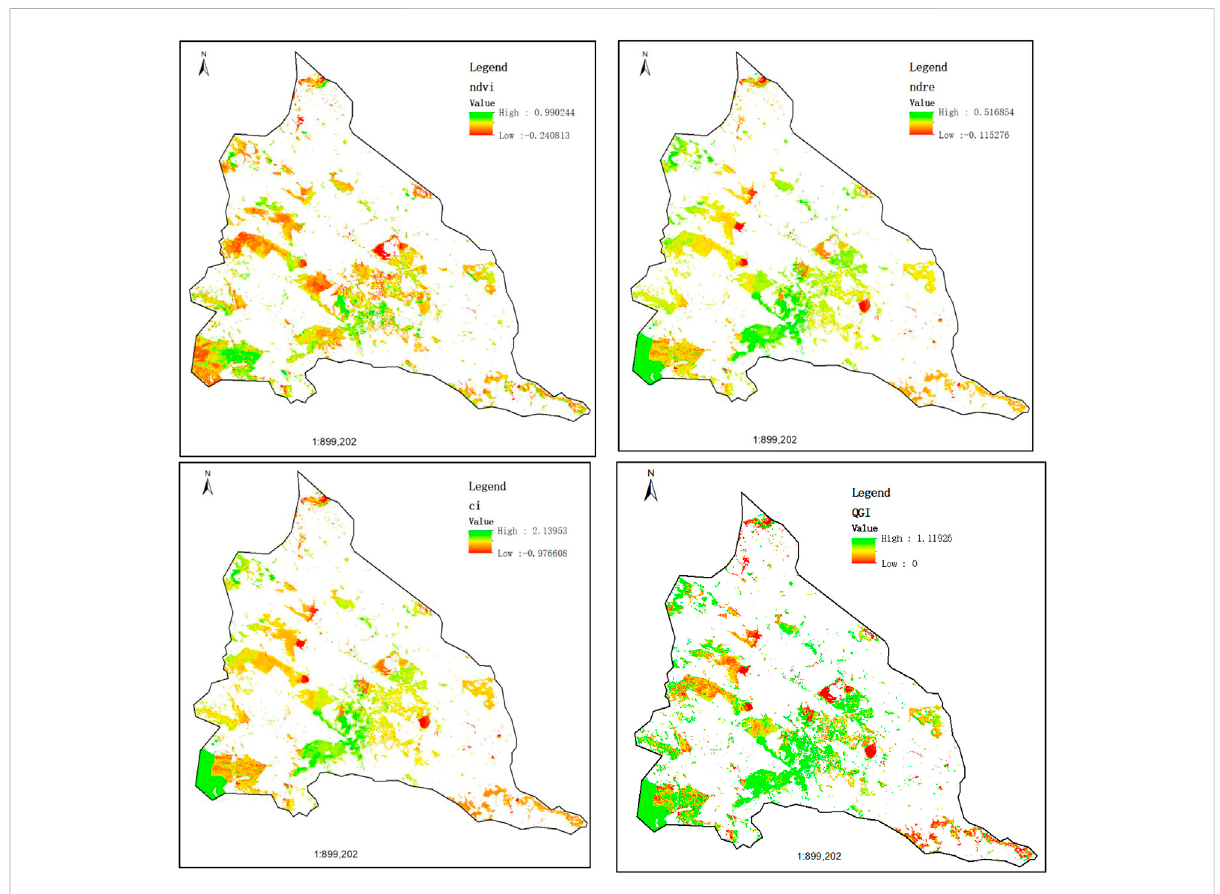
FIGURE 4 Results of study area NDVI, NDRE, and CI red − edge and the